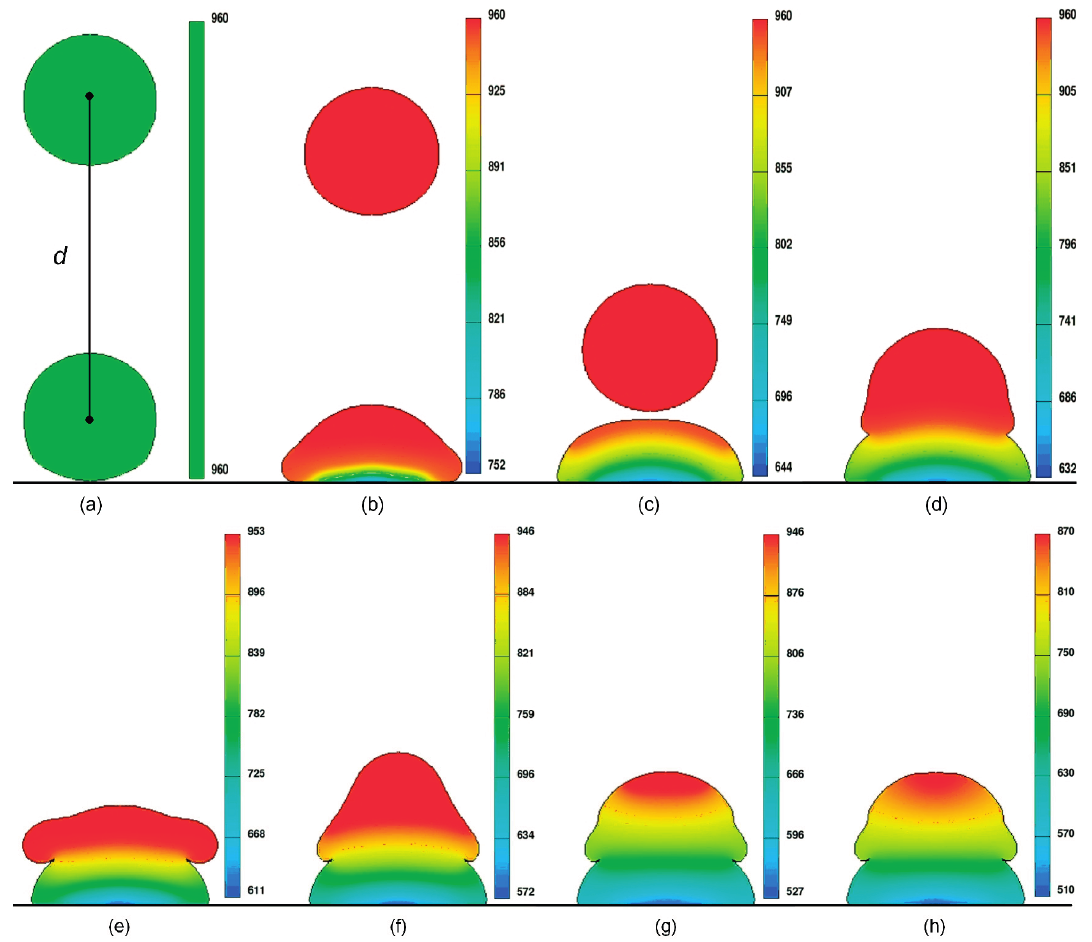
Figure 4. Simulated deformation and temperature distribution of a 100- μ m diameter aluminum alloy droplet, initially at 960 K, and its impingement on a stainless substrate at a velocity of 2.5 m/s; the distance between the two successive droplets is 240 μ m and time is measured from the moment of impact: ( a ) t = 0 μ s; ( b ) t = 15.5 μ s; ( c ) t = 71.3 μ s; ( d ) t = 83.7 μ s; ( e ) t = 102.3 μ s; ( f ) t = 158.1 μ s; ( g ) t = 241.8 μ s; and ( h ) t = 272.8 μ